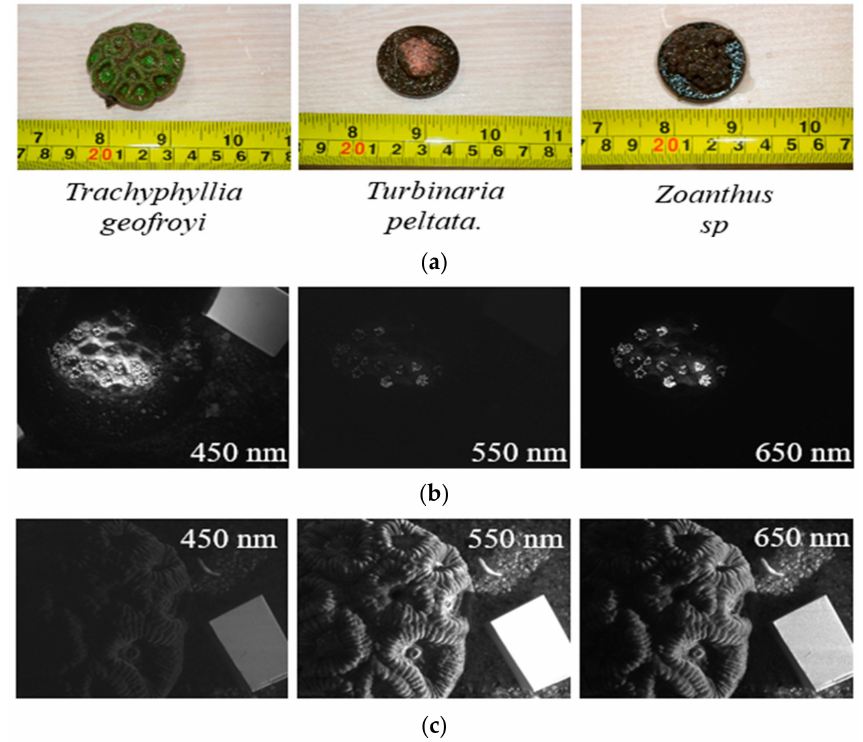
Figure A3. ( a ) RGB images indicating the specie size. ( b ) Spectral images of Turbinaria Peltata , illuminated by blue light. ( c ) Spectral images of Trachyphyllia Geofroyi illuminated by white light.